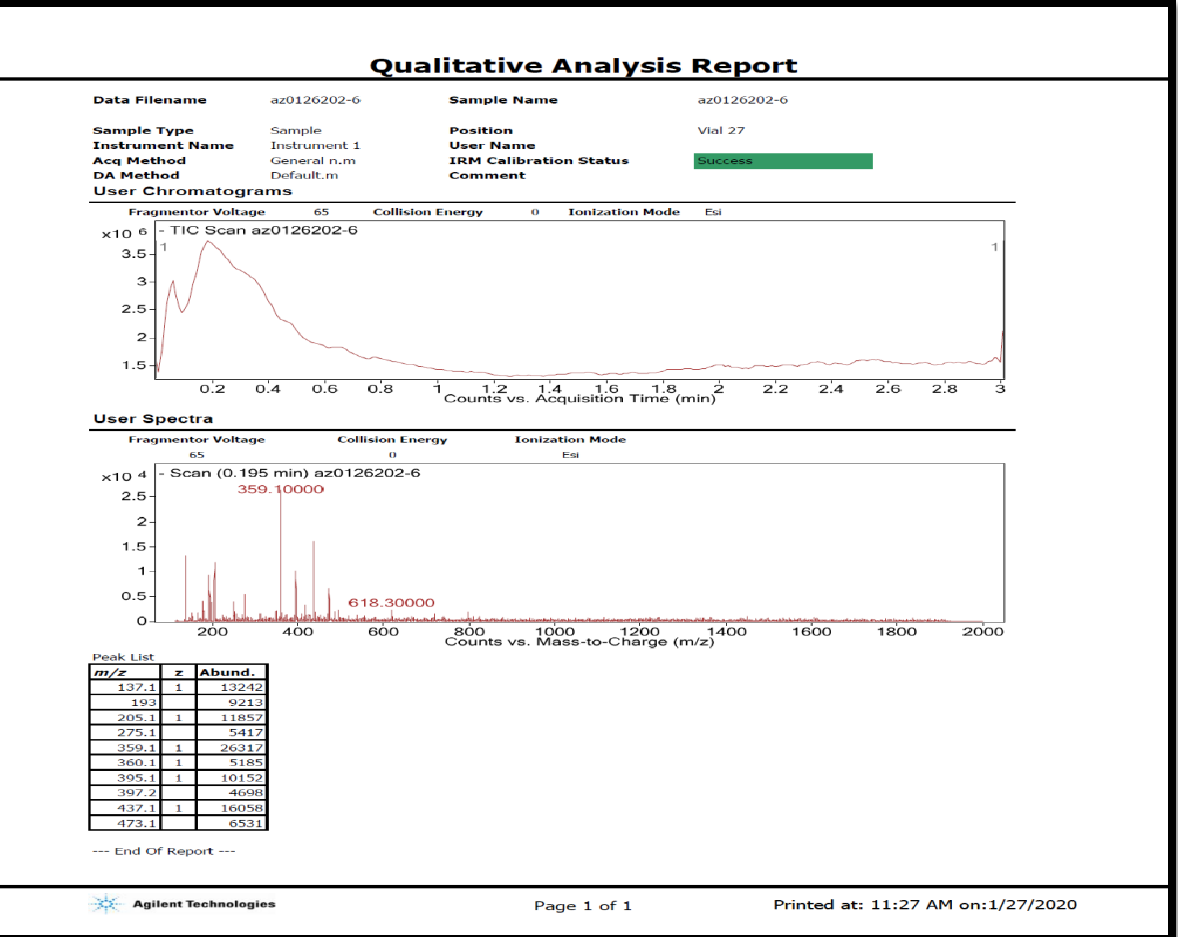
Figure 20. LC/MS chromatogram of isolated compound number 1 Molecular ion peak at m/z 360 that correspond to a molecular formula of C18H16O8(3,4- dihydroxyphenyllactic acid) Rosmarinic acid and